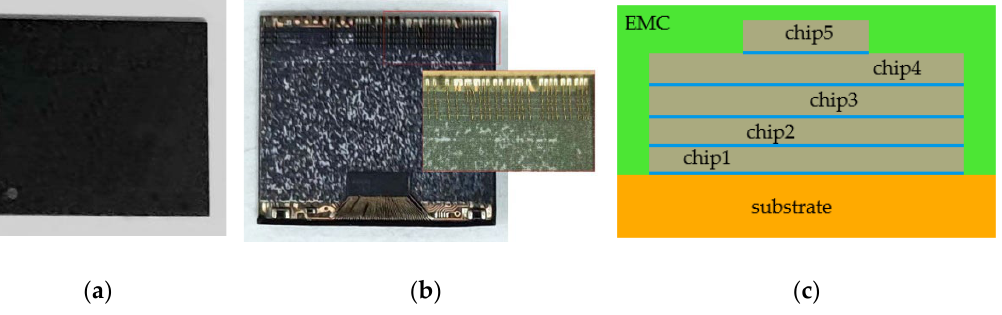
Figure 1. Three-dimensional-stacked package memory chip structure. ( a ) Package outline; ( b ) laser decap package sample and its left-top corner detail picture; ( c ) package cross-section schematic (chips 1 to 4 are memory chips, and chip 5 is a main-control chip). Table 1. Packaging size and material